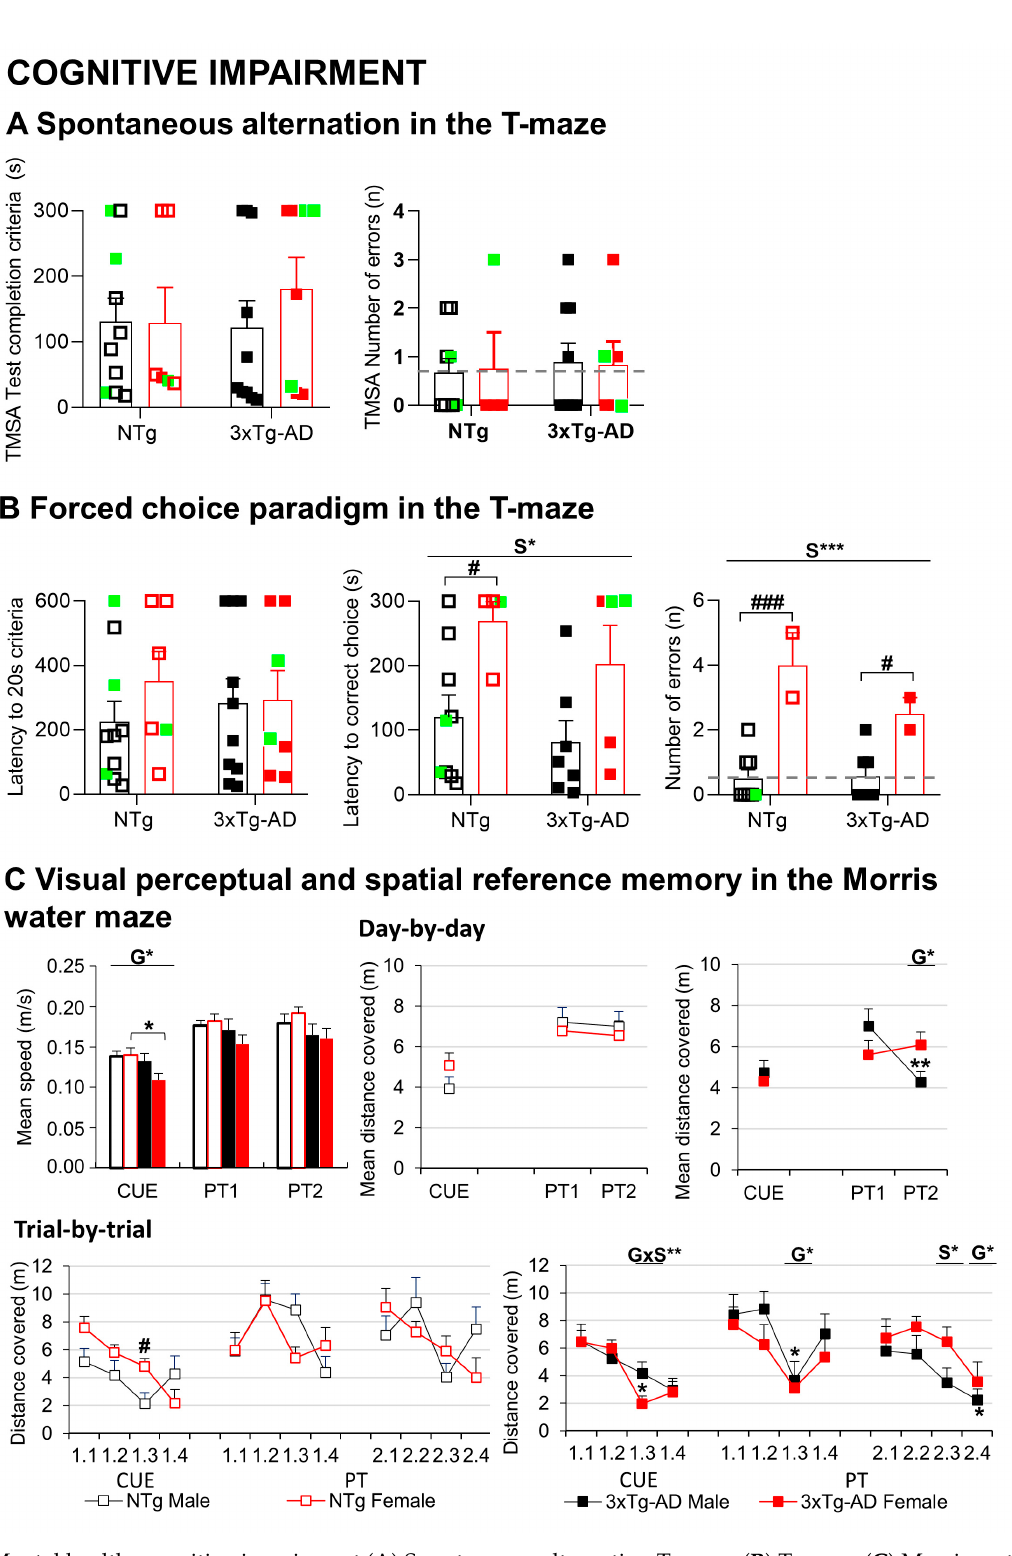
Figure 3. Mental health: cognitive impairment ( A ) Spontaneous alternation T-maze, ( B ) T-maze, ( C ) Morris water maze. Results are the mean SEM. Bars illustrate the genotype groups, as indicated in the abscissae. Symbols are used to illustrate ± individual values of males (black, left panel) and females (red, right panel). In green: the no-survivors. Genotype (G) and sex (S) effects and GxS interaction were analyzed by 2 2 factorial ANOVA analysis, * p < 0.05, ** p < 0.01, *** p < 0.001 × (above line). Student t -test comparisons: * p < 0.05, ** p < 0.01, *** p < 0.001 vs. the corresponding NTg group; # p < 0.05, ### p < 0.001 vs. the corresponding male group.